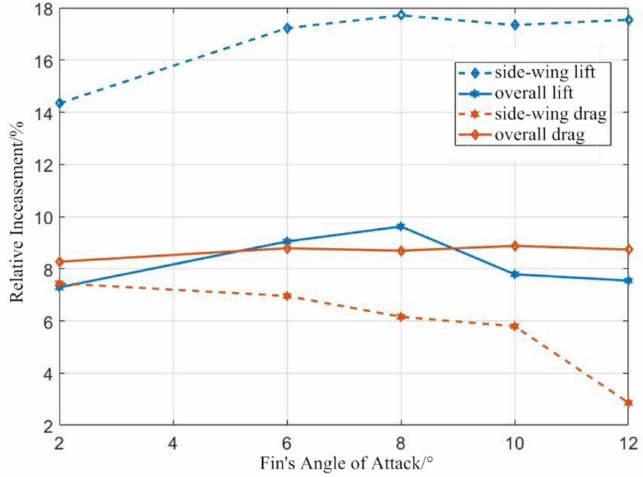
Figure 15. Influence of fin’s angle of attack α to side wing aerodynamic